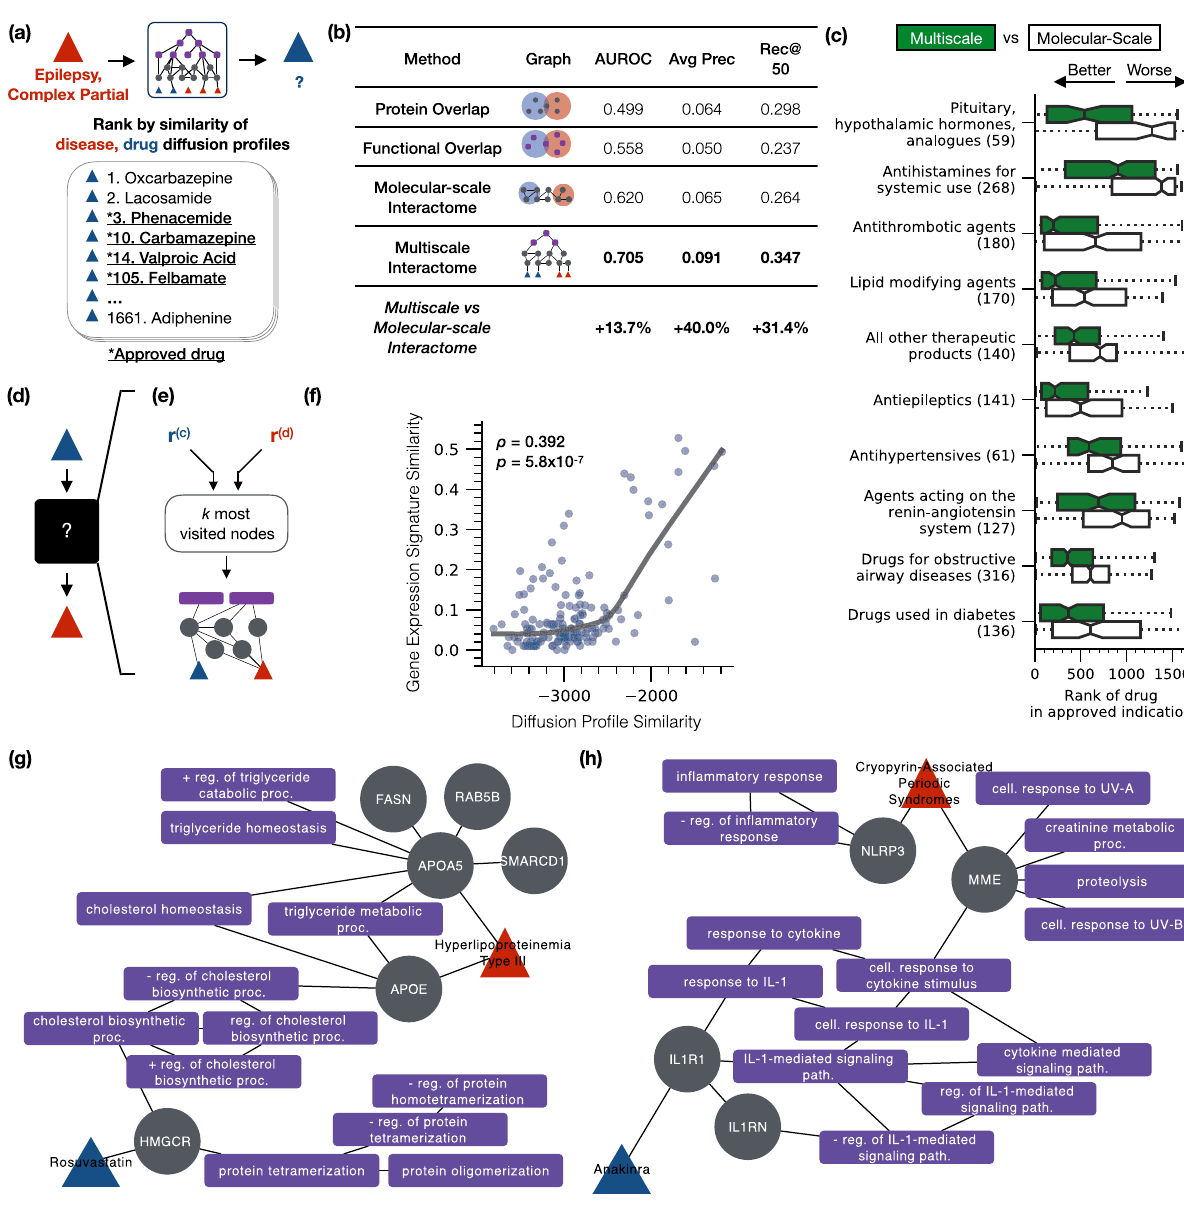
NATURE COMMUNICATIONS| (2021) 12:1796 |https://doi.org/10.1038/s41467-021-21770-8|www.nature.com/naturecommunications